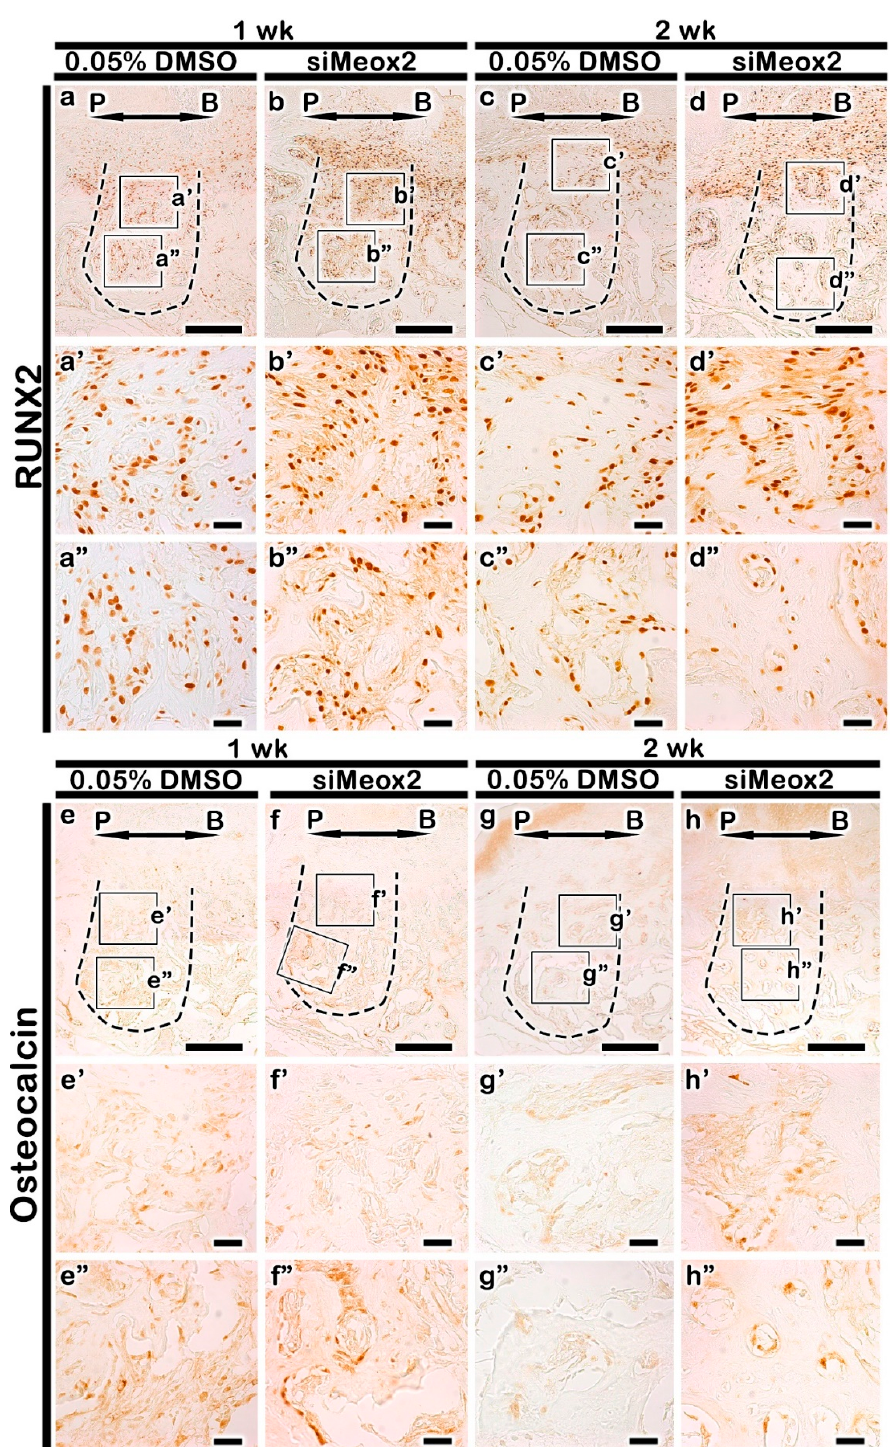
Figure 4. Immunolocalization of pre-osteoblast ( a – d ) and mature osteoblast ( e – h ) during bone formation. After 1 week of treatment, the carrier control (DMSO)-treated specimens showed a increase in Runx2 level ( a ) compared with that in si Meox2 specimens ( b ). The number of Runx2 positive cells lower in carrier control-treated specimens ( c ) than in si Meox2 treated specimens ( d ) after 2 weeks of